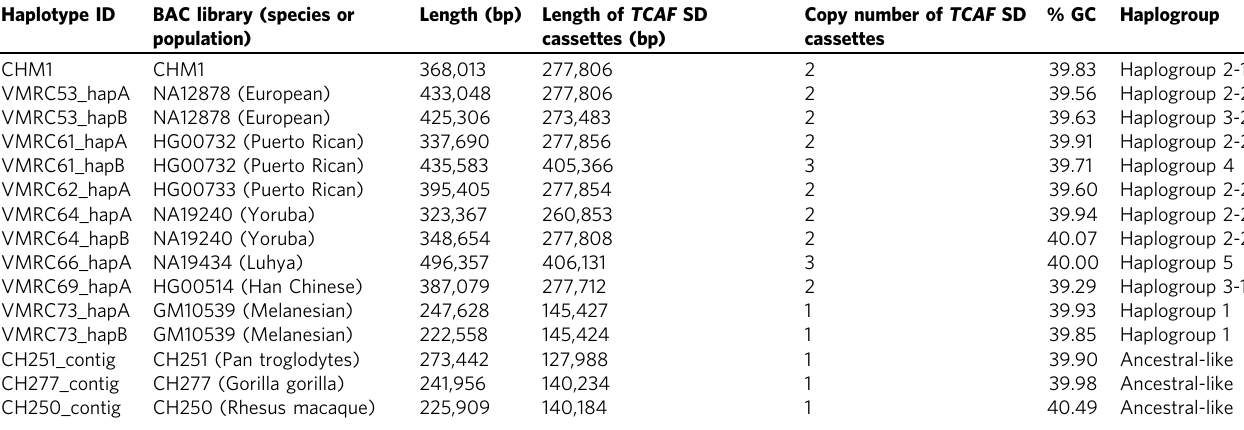
BAC clones were selected and sequenced using the PacBio long-read sequencing technology and assembled into individual haplotypes (Methods). Copy number of TCAF segmental duplication (SD) cassettes and the classi fi cation for individual haplotypes were determined by Miropeats and sequence alignment analysis (Fig. 2 and Supplementary Figs. 5 –